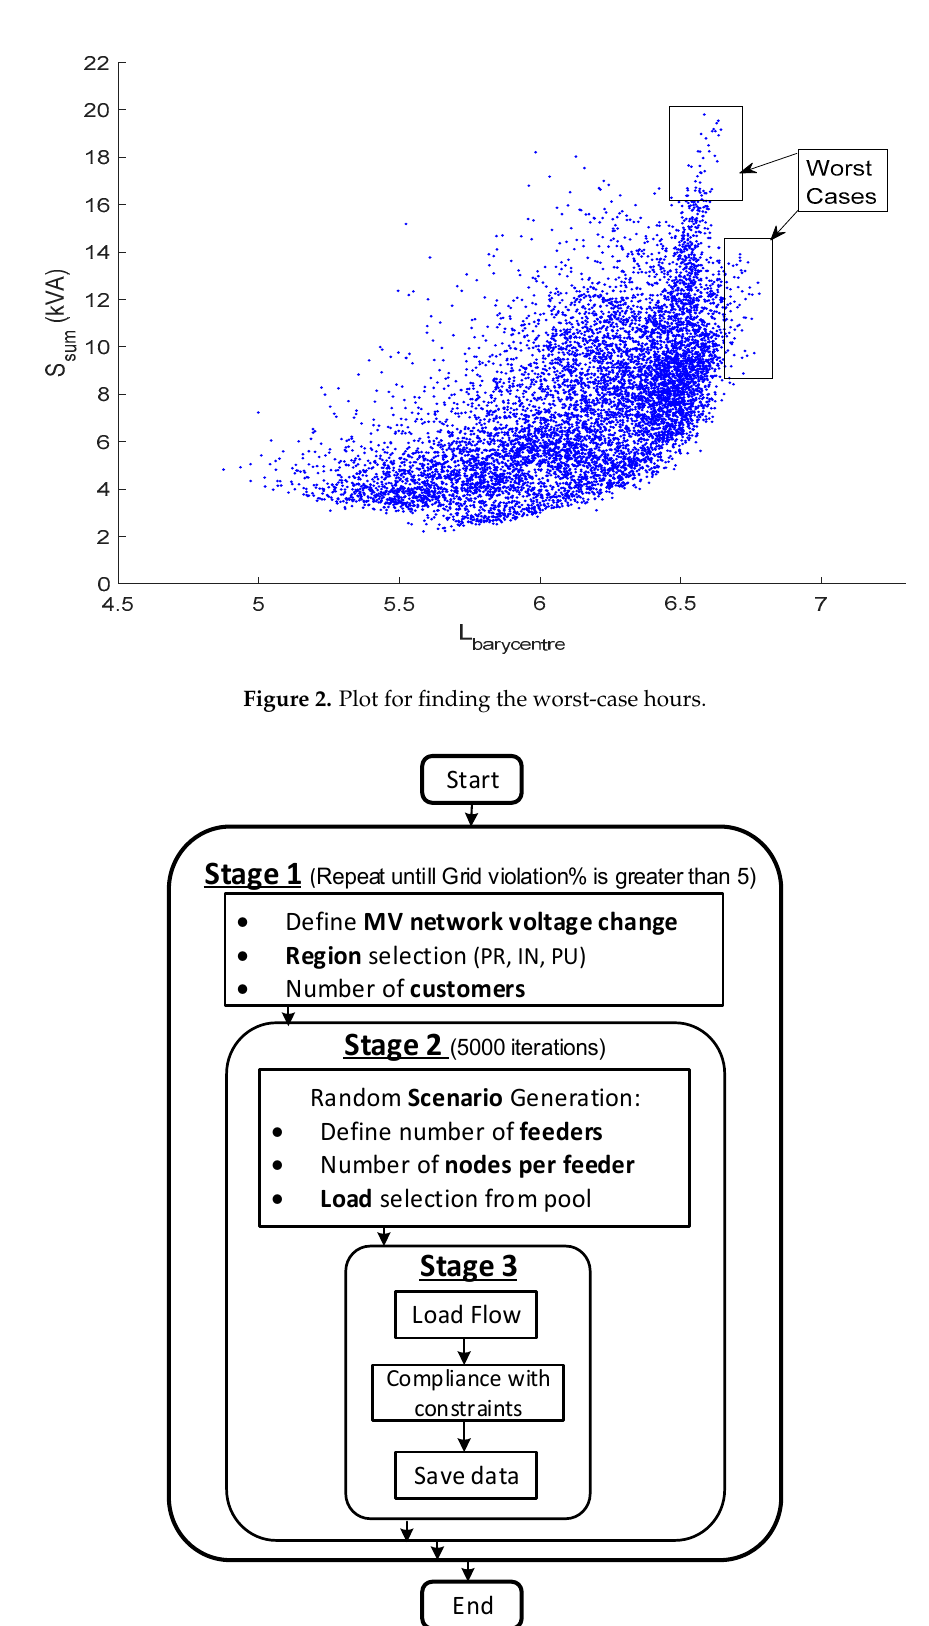
End Figure 3. Monte Carlo based algorithm for test network generation, MV represents medium voltage.